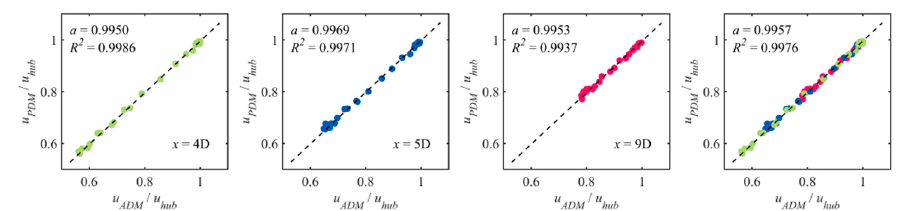
Figure 13. Relationship between the driving modes under the ABL condition in terms of the mean wake velocity.